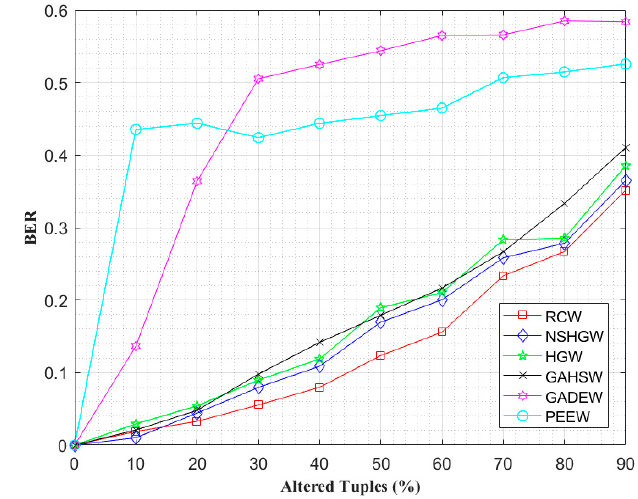
Figure 5. Alteration attacks BER comparison for RCW, NSHGW, HGW, GAHSW, PEEW, and GADEW algorithms.